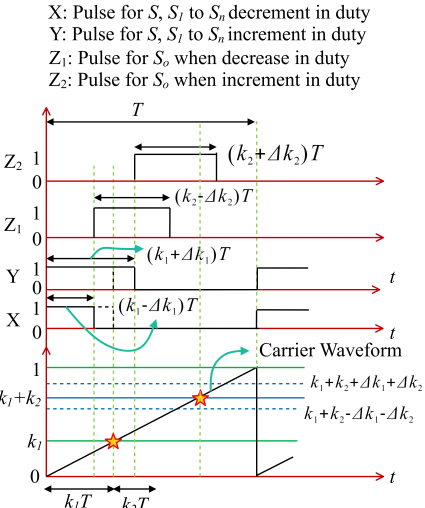
Figure 14. Control scheme-3, (X: variation in the duty cycle of switches S , S 1 − S n when voltage is increased at the input side, Y: variation in the duty cycle of switches S , S 1 − S n when voltage is decreased at the input side, Z 1 : the duty cycle of switch S o is shifted and varies when voltage is increased at the input side, Z 2 : the fixed duty cycle of switch S o is shifted and varies when voltage is decreased at the input